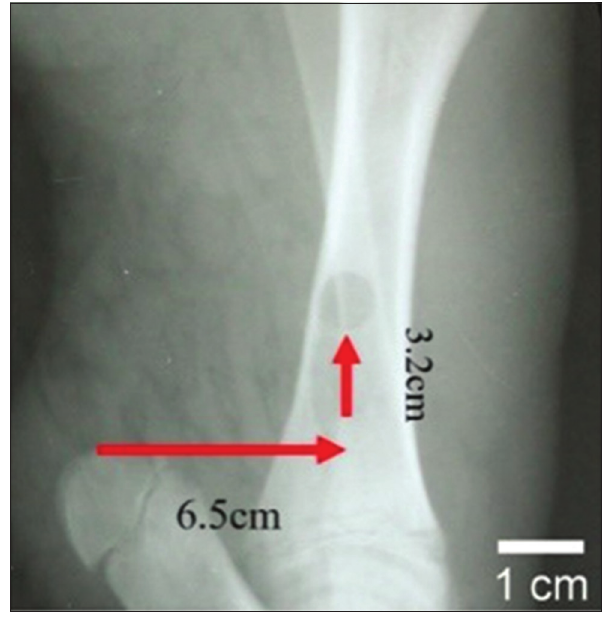
Figure-1: Incision at medial tibia with synchronized orientation of 6.5 cm horizontal from the calcaneal tuber and 3.2 cm vertical towards